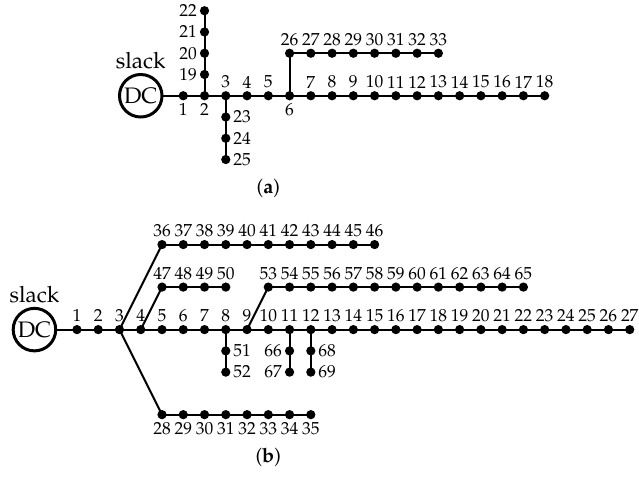
Figure 3. Test feeder topologies: ( a ) 33-bus grid and ( b ) 69-bus grid. Table 1. First test feeder, composed of 33